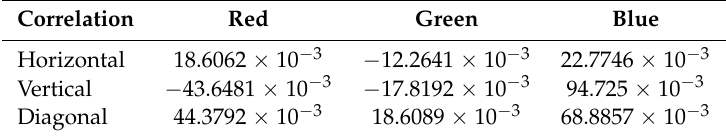
Table 9. Correlation coefficients of the Lena RGB cryptogram using Rössler